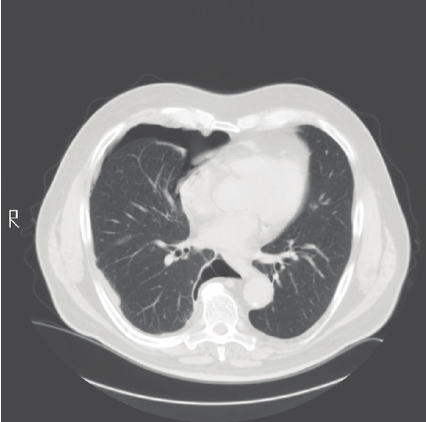
Figure 3: Chest CT scan in March